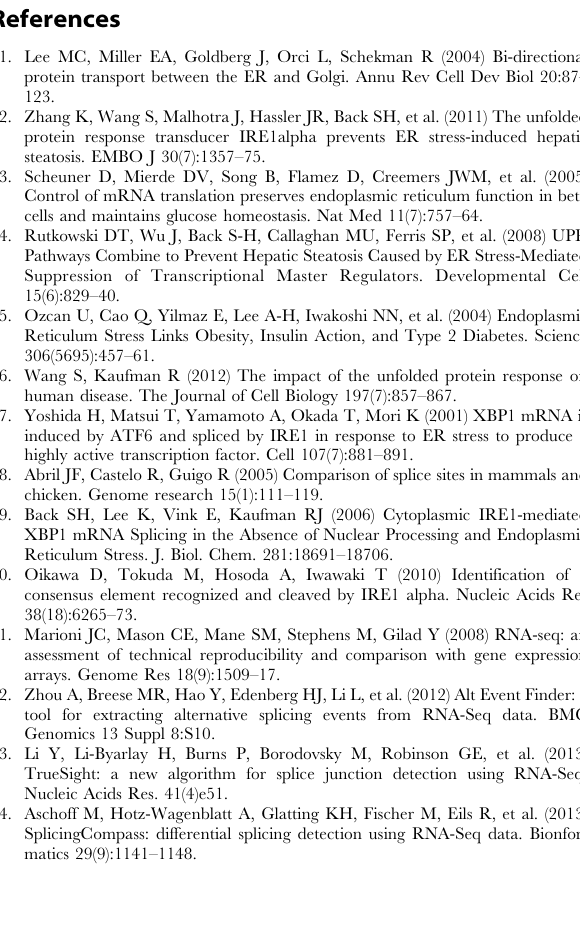
Table S4 Overlap between RSW results with exon junctions of protein isoform IDs identified by another SKBR3 study. Table S5 A list of novel splice junctions reported by RSW algorithm for human breast cancer chromosome 17 RNA-Seq